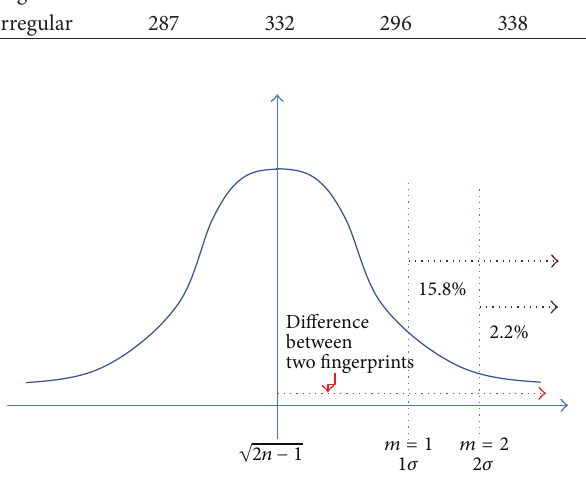
Figure 10: Statistical threshold